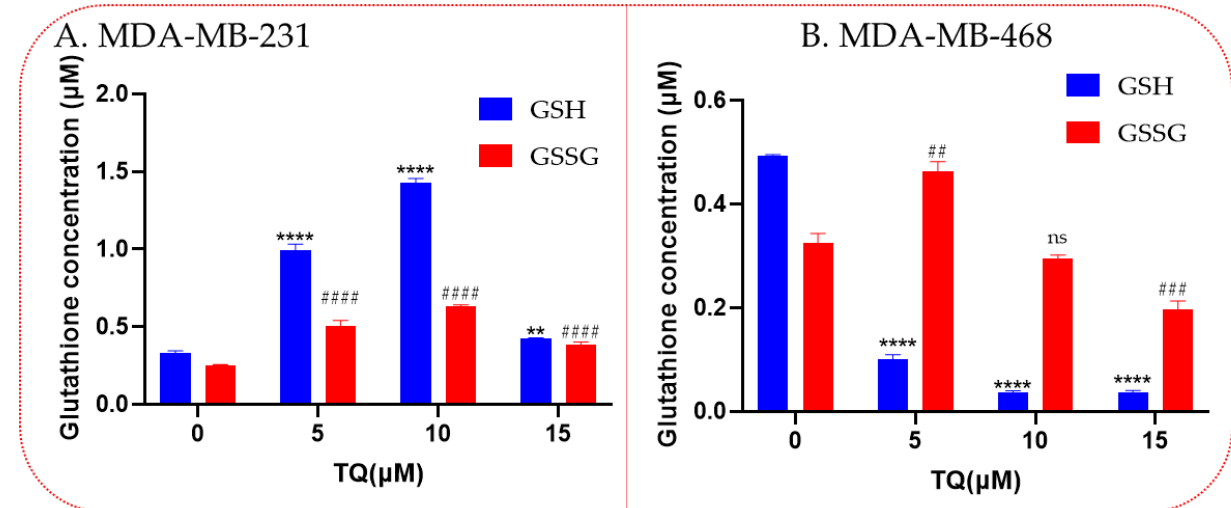
Figure 6. Glutathione activity in TQ-treated TNBC cells. For this study, 1.5 × 10 6 cells/well/6-well plate was incubated at night, then treated for 24 h with TQ at various concentrations. GSH activity was displayed for MDA-MB-231 cells ( A ) and MDA-MB-468 cells ( B ). Asterisks show that Glutathione activity has significantly changed when compared to controls. Each bar indicates the mean ± SEM of three replications using one-way ANOVA. The effect is statistically significance at ** p < 0.01, **** p < 0.0001, ## p < 0.01, ### p < 0.001, #### p < 0.0001 and ns; non-significant. Compared with the control, (*) refers to the significant change in GSH, meanwhile (#) refers to the significant change in GSSG.